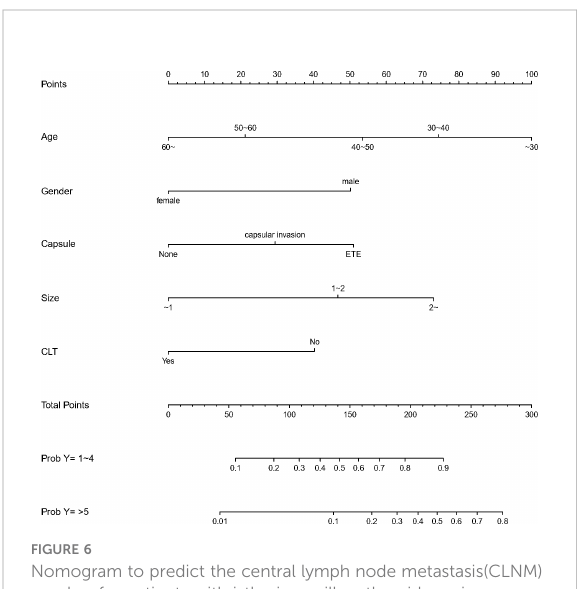
FIGURE 6 Nomogram to predict the central lymph node metastasis(CLNM) number for patients with isthmic papillary thyroid carcinoma (IPTC). CLNM,central lymph node metastasis; IPTC,isthmic papillary thyroid